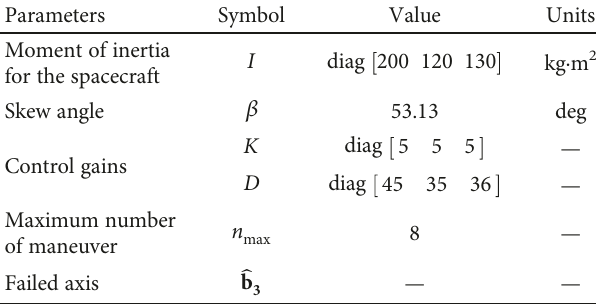
Table 1: Numerical simulation